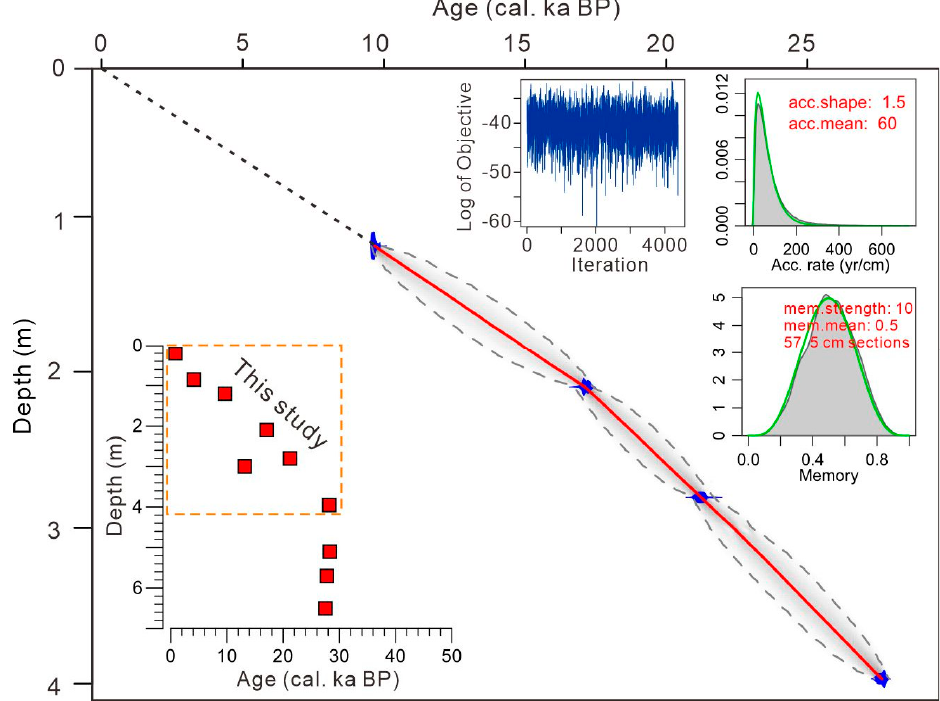
Figure 2. Bayesian age − depth model of the ZSP section based on previous AMS 14 C dates [45].